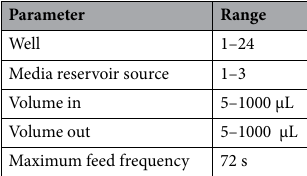
Table 1. Experiments run on the Autoculture system are configurable in any combination of the listed parameters and